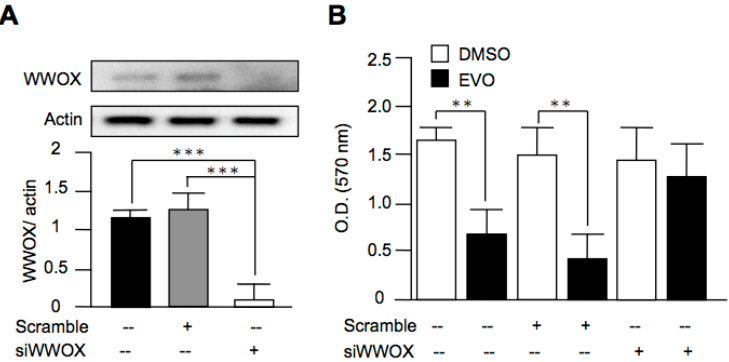
Figure 6. Evodiamine inhibited Hepa1-6 cell proliferation through a WWOX-dependent pathway.